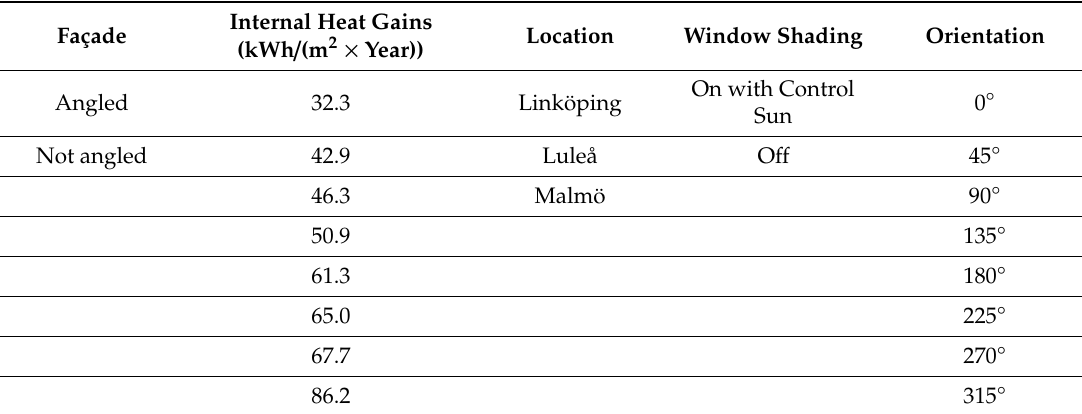
Table 2. The variation of the variables used in the parametric study. Control Sun means that the blinds are activated when the sun hits the